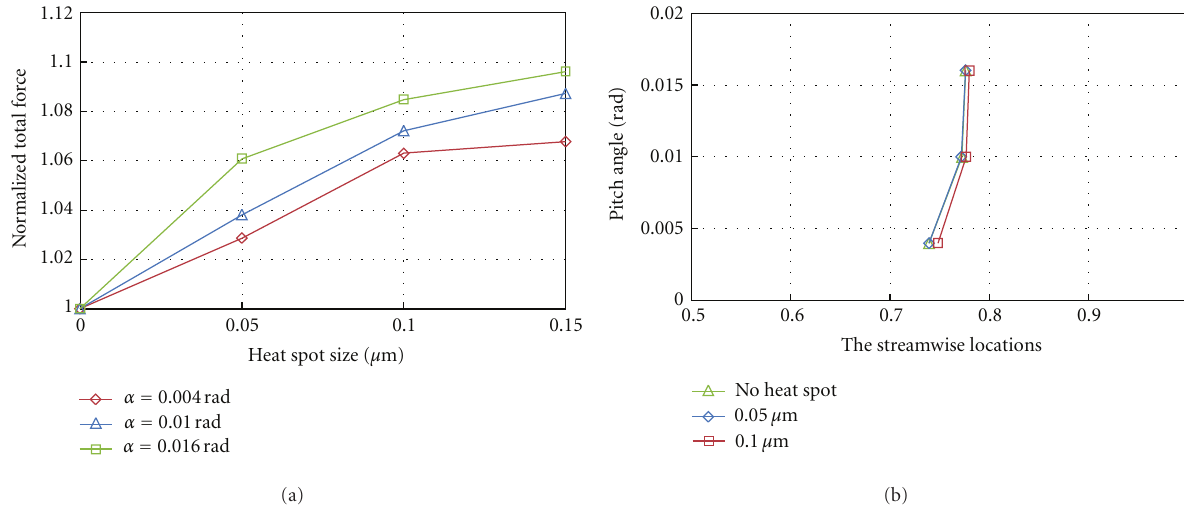
Figure 6: The variations of (a) total bearing force acted on the slider surface and (b) positions of resultant force with the heated spot size for di ff erent pitch angles. The normalized total force represents the respective total force with a heated spot divided by the total force without a heated spot.